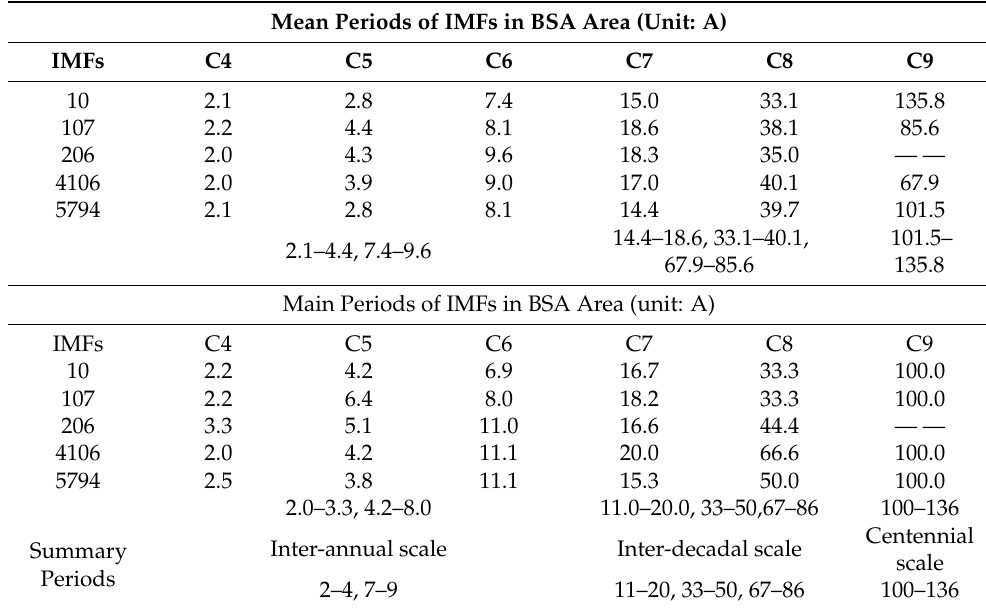
Table 5. Multi-scale periodic analysis of precipitation in areas around the Baltic Sea area (BSA). Mean Periods of IMFs in BSA Area (Unit: